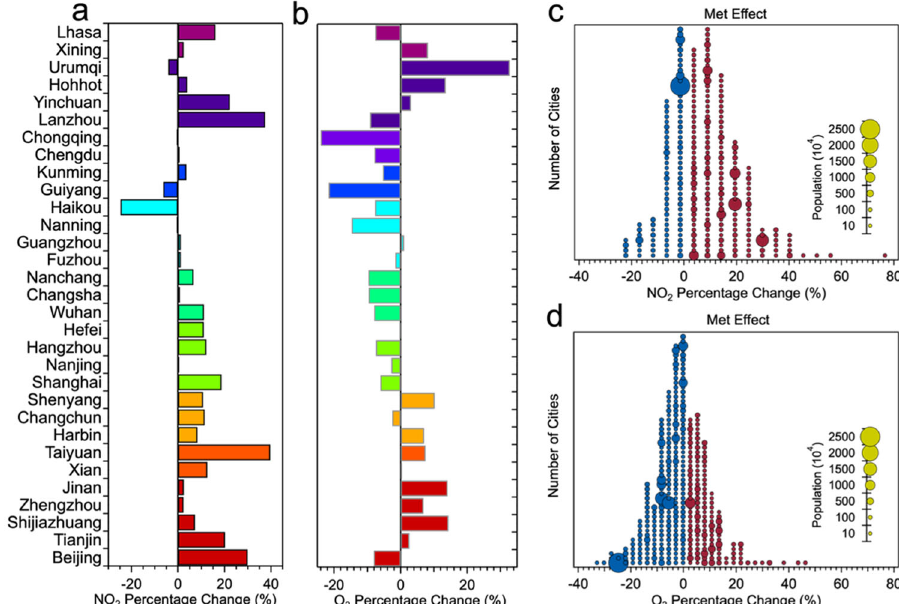
Fig. 3 City-level NO 2 and O 3 changes attributable to meteorological drivers. a , b show the average NO 2 and O 3 changes in 31 capital cities in each province and c , d show the city number distributions of NO 2 and O 3 percentage changes attributable to the meteorological drivers in each city across China during the Total COVID-lockdown period, respectively. Red solid circles represent cities with increased percentages, blue solid circles represent cities with decreased percentages. The size of the circles represents each city ’ s